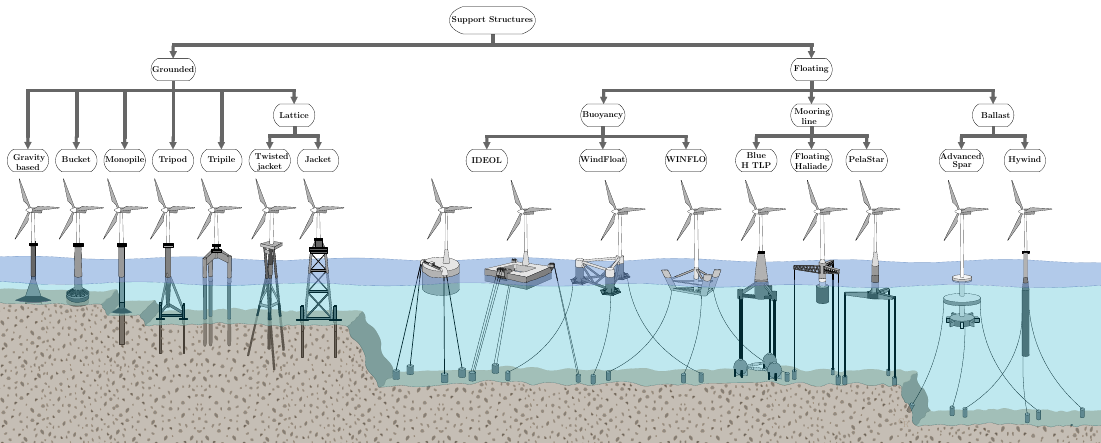
Figure 9. Most common grounded turbine support structures and several existing floating solutions